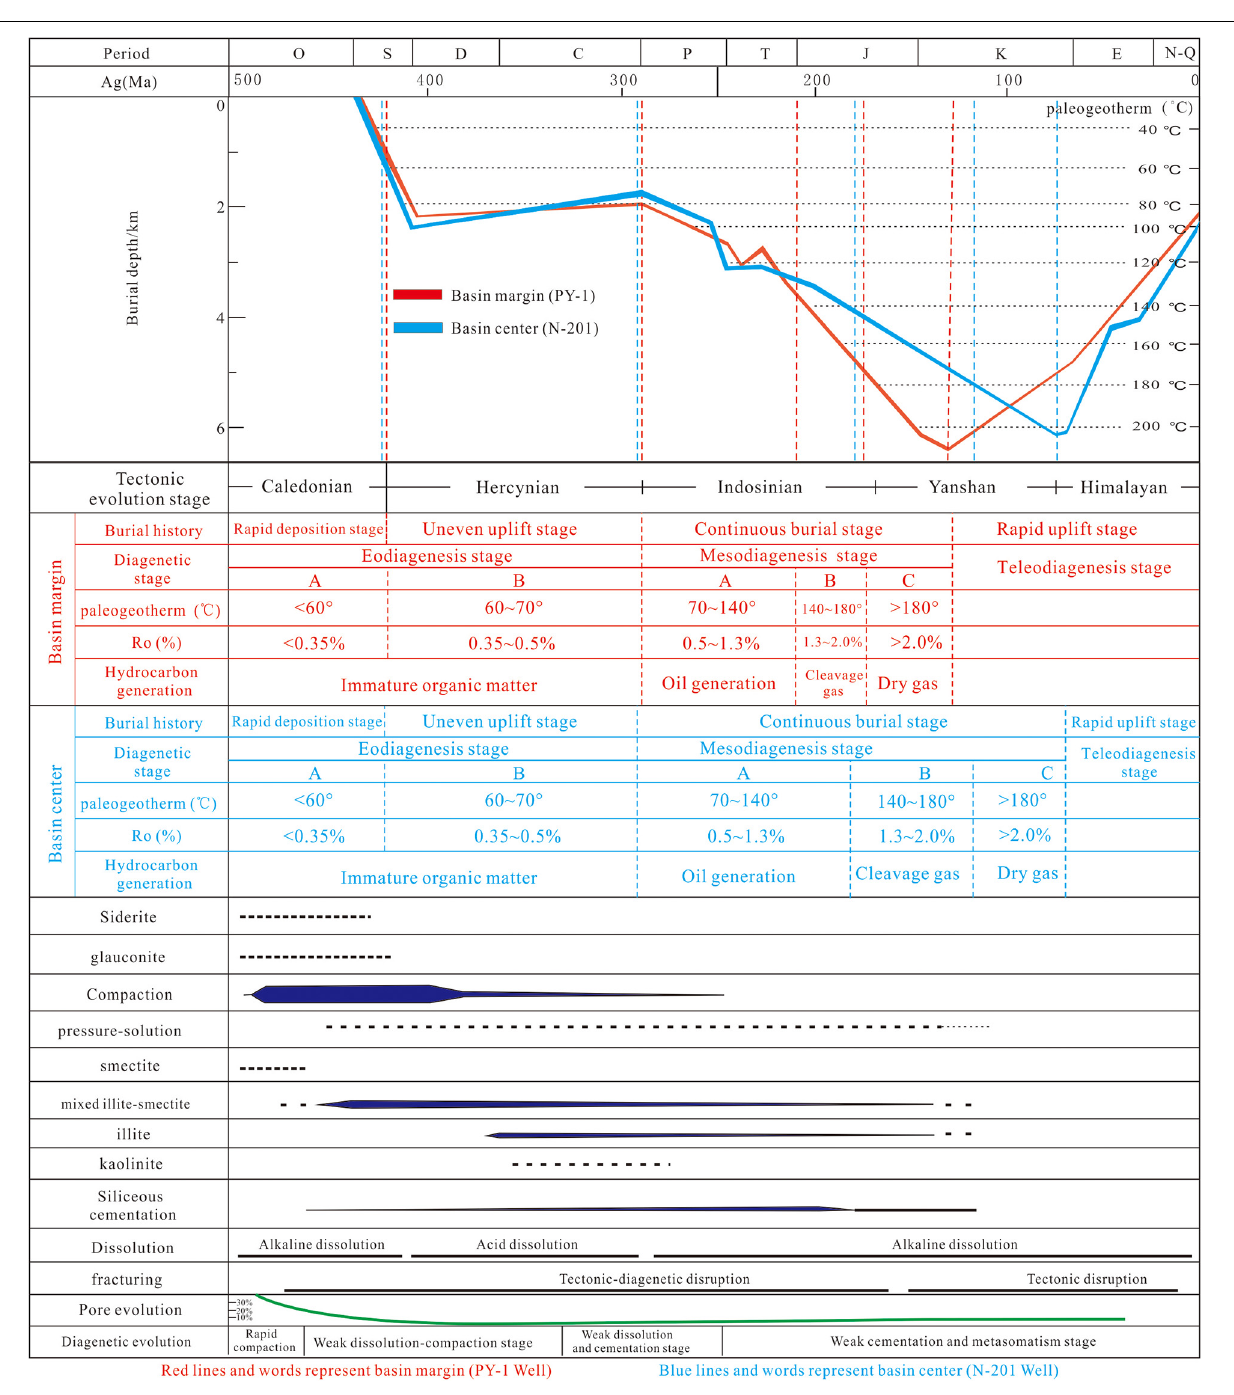
FIGURE 6 | Burial history, thermal history, and diagenetic evolution sequence of the Longmaxi Formation shale in the Sichuan Basin (the burial evolution and thermal history of well PY-1 referenced from Xu et al. (2015); the burial evolution and thermal history of well N-201 referenced from Liu et al. (2020); the diagenetic evolution sequence is modified after Wang et al. (2015)). Based on the burial history, combined with the characteristics of burial depth, temperature, thermal maturity of organic matter, authigenic mineral groups and relationships, and diagenesis, the diagenetic evolution process of different areas in Sichuan Basin is